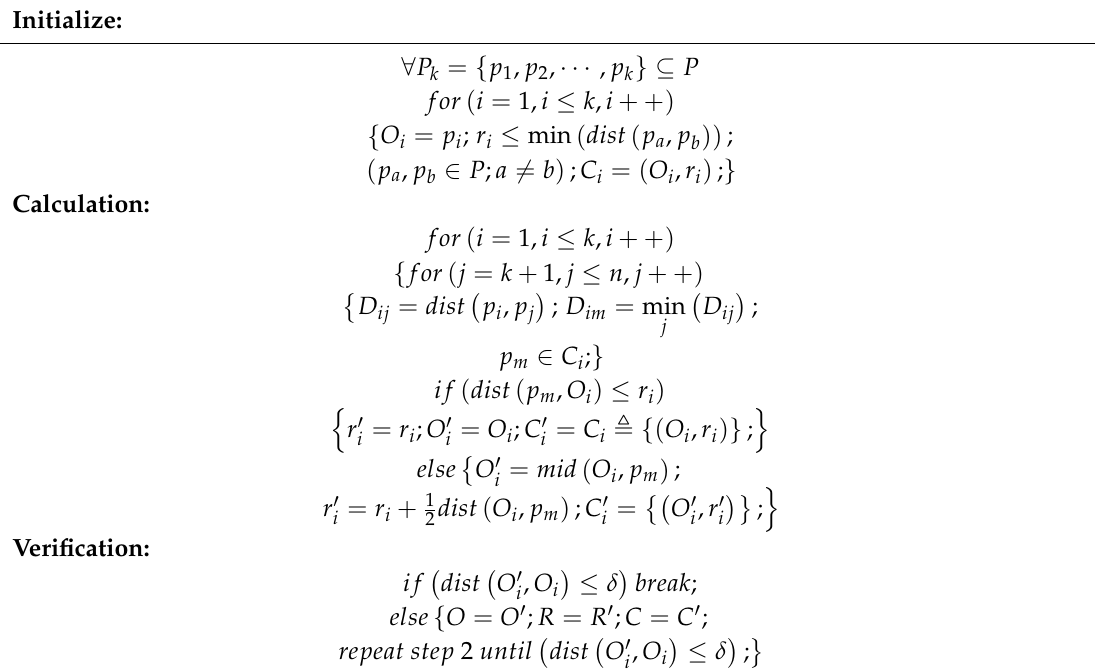
Algorithm 1: Smallest Enclosing Circle (SEC) Clustering